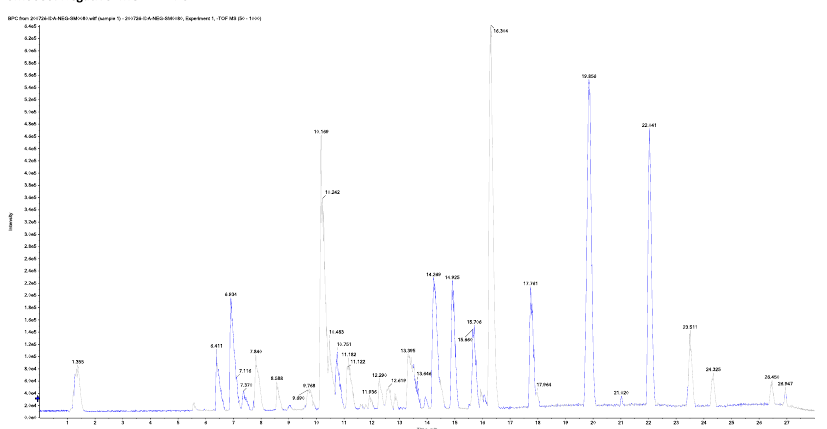
Figure 5. Chromatogram of methanolic extract of M. alysson L. in negative ion mode.